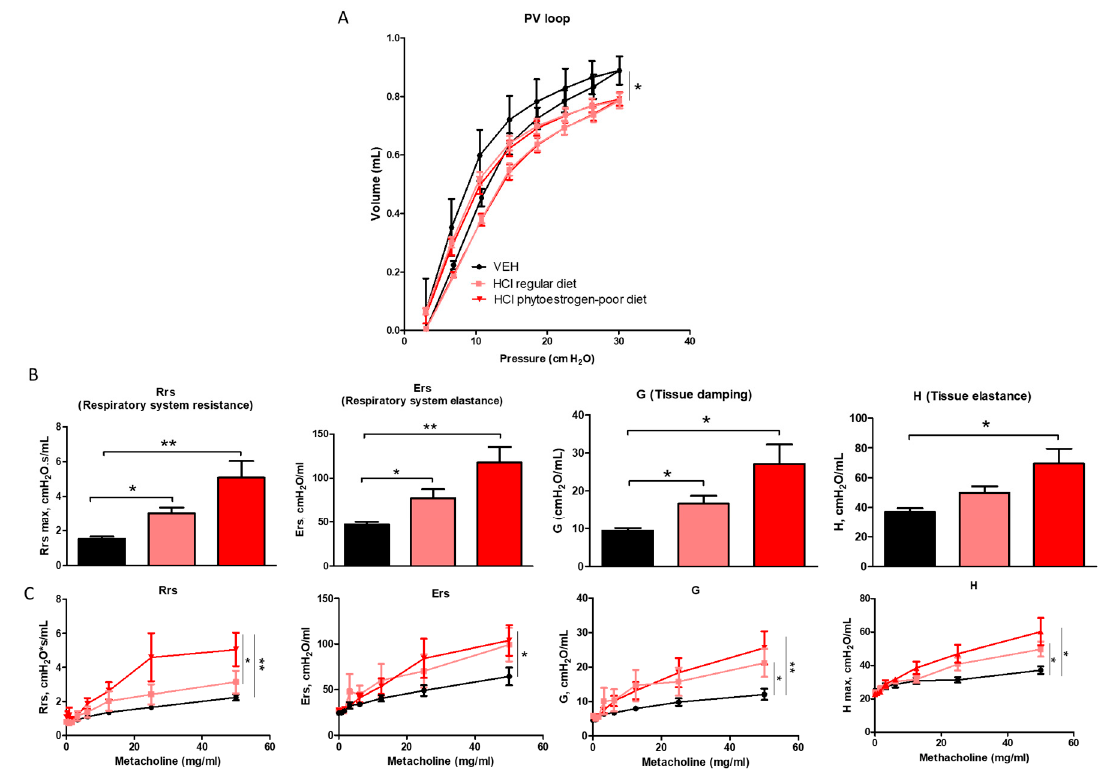
Figure 7. Effect of dietary phytoestrogens on HCl-induced alterations in lung mechanics. Phytoestrogen diet had a significant impact on preventing a downward shift of pressure volume (PV) loops after HCl instillation ( A ). Respiratory system resistance (Rrs), elastance (Ers), tissue elastance (H), and damping (G) increased, compared to control mice in all groups instilled with HCl ( B , C ). Means ± SEM; n = 6 mice per group; *: p < 0.05, **: p < 0.01, with one- or two-way ANOVA and Tukey’s; VEH: Vehicle.